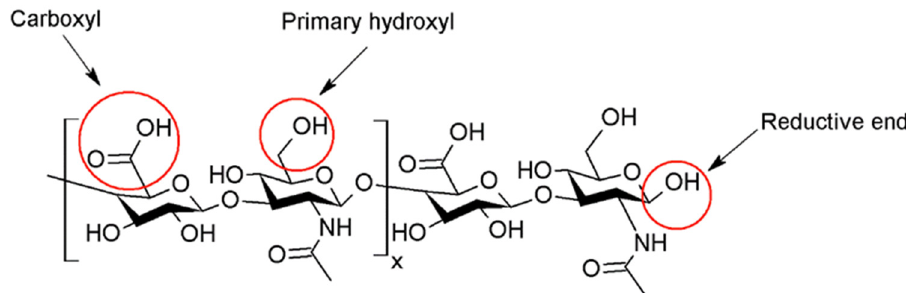
Figure 1. Chemical structure of native HA and functional groups used for its modification.